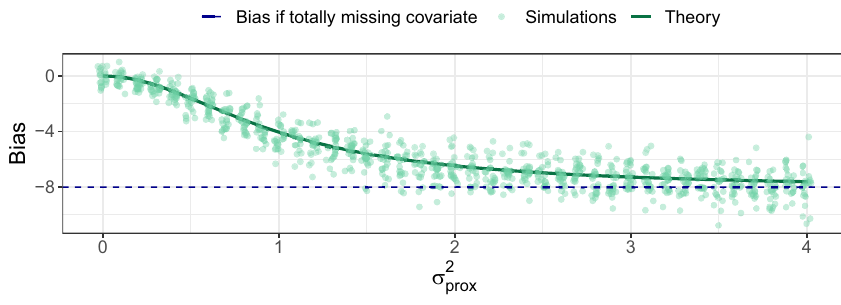
Figure A2: Simulation results for proxy variable ( procedure 5 ) Simulation when a key covariate is replaced by a proxy following the proxy - framework ( see Assumption 8 ) . The theoretical bias ( 1 ) is represented along with the empirical values obtained when generalizing the ATE with the plugged - in G - formula estimator.